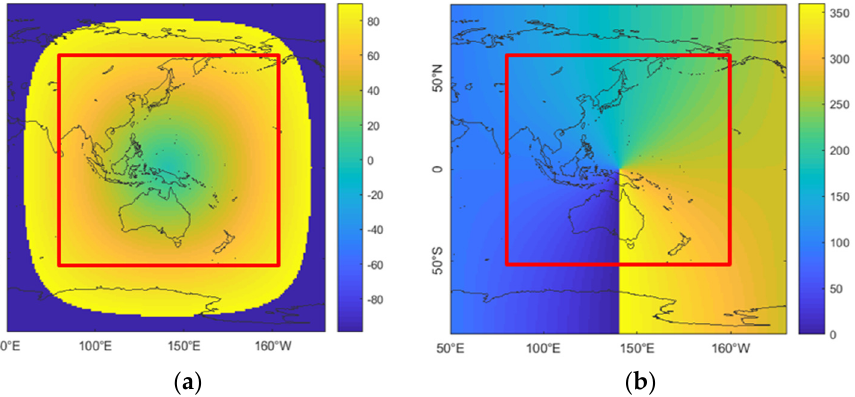
Figure 3. The spatial distribution of viewing angles for the AHI. ( a ) VZA. ( b ) VAA. The red rectangles refer to the effective observation scope of AHI. Table 2. Quality control for the AHI data.